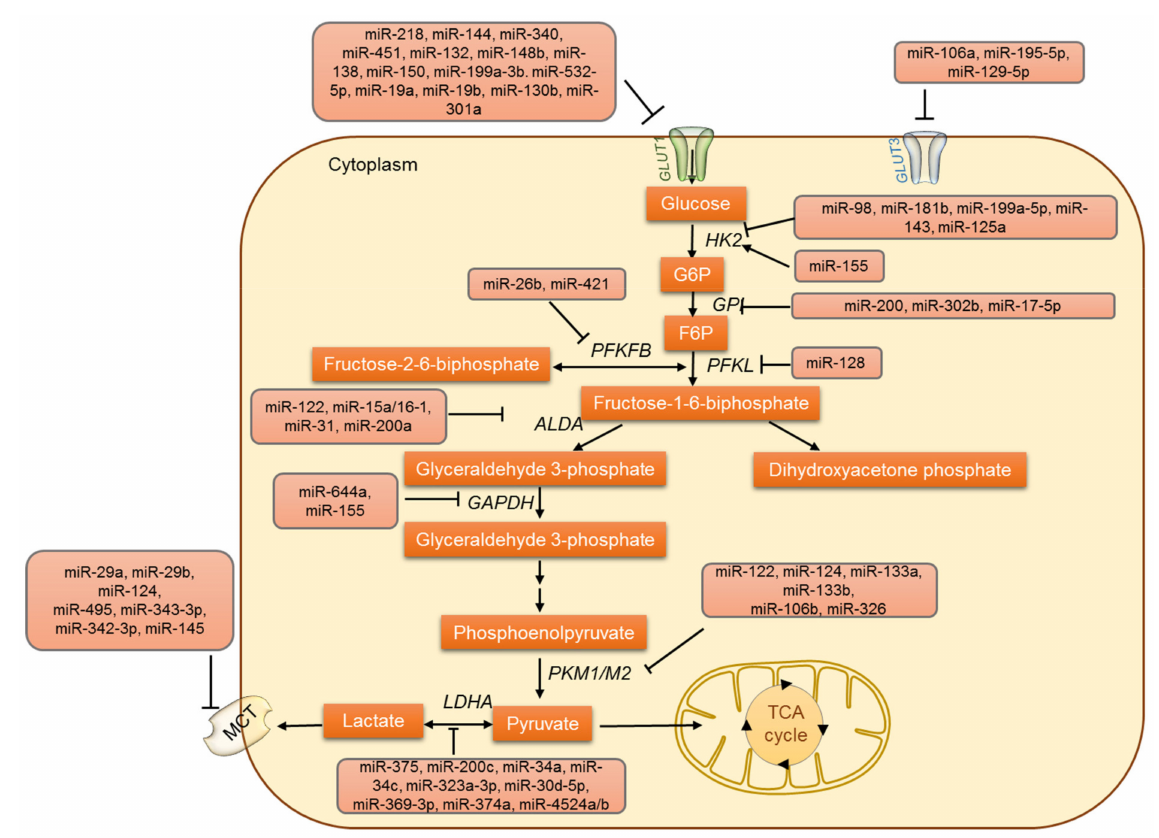
Figure 1. The regulation of glucose uptake, glucose oxidation and lactate metabolism by